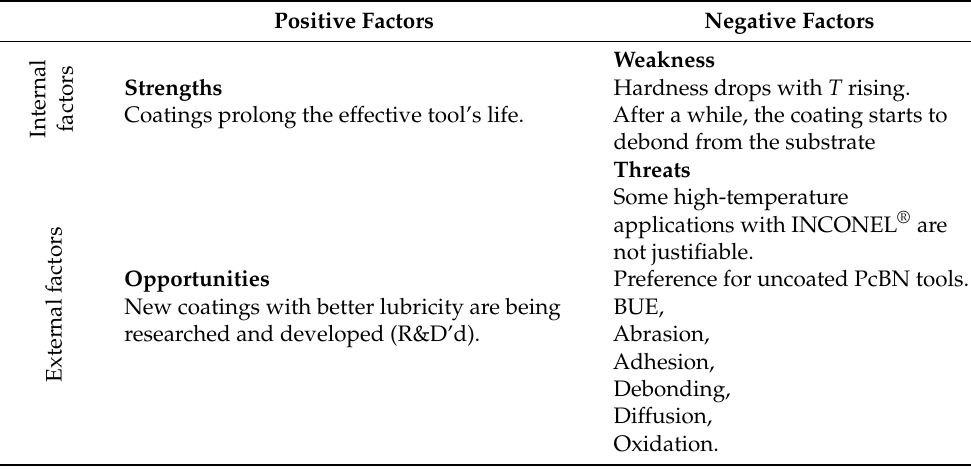
Table 15. SWOT analysis about cutting tools